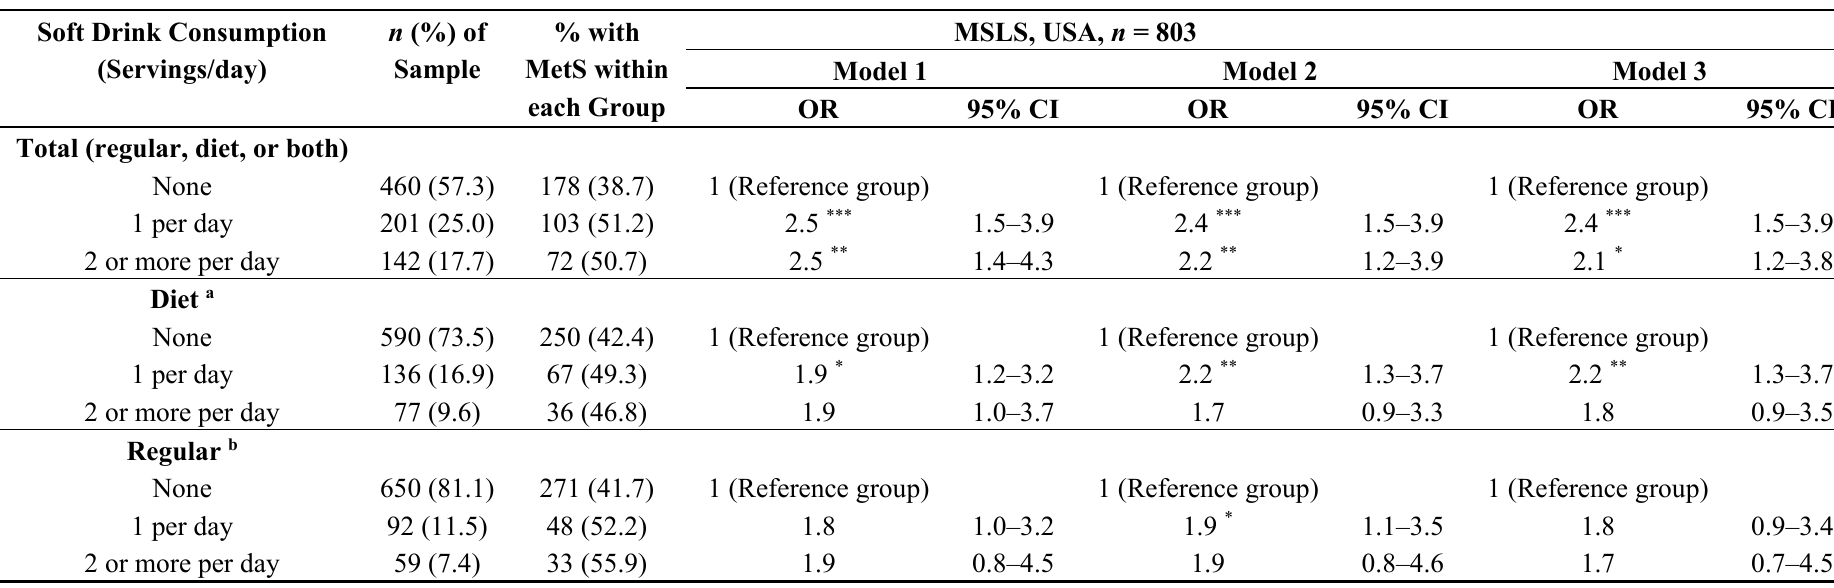
Table 2. Cross-sectional relationships between soft drink consumption with prevalence of MetS in MSLS ( N = 803). Soft Drink